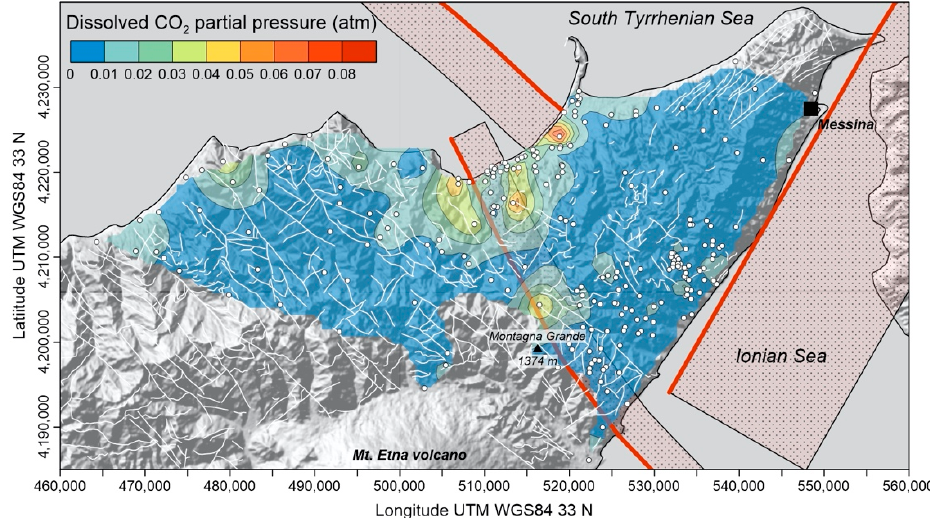
Figure 14. Spatial distribution of PCO 2 , reporting locations of sampling points and tectonic lineaments (white lines). The thick red lines, with associated red dotted areas, represent the main faults (lines) and seismogenic sources (areas) by [39].